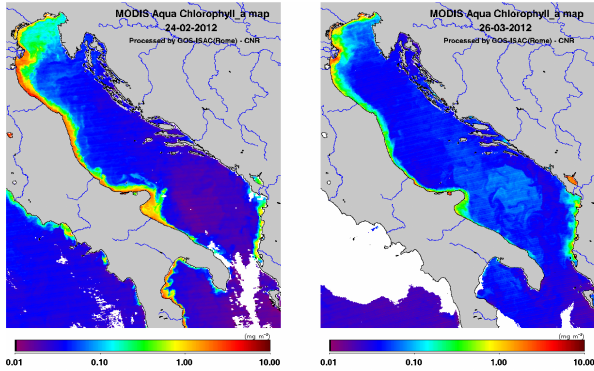
Figure 3. Satellite image (MODIS Aqua Chlorophyll a map, pro- cessed by GOS-ISAC (Rome) – CNR) of surface chlorophyll a (µgL − 1 ) distribution in the Adriatic Sea on 24 February 2012 and 26 March 2012. Table 1. Depth of the productive layer (PL) for the respective cruise and station.